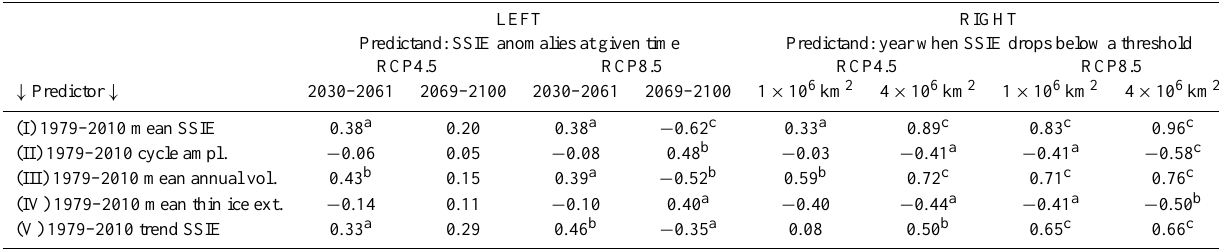
Table 2. Inter-CMIP5 models correlations between five 1979–2010 Arctic sea ice predictors (I mean SSIE; II amplitude of the mean seasonal cycle of sea ice extent; III mean annual volume; IV mean sea ice extent of thin (0.01–0.5m) ice in September; V linear trend in SSIE) and (LEFT) the 2030–2061 and 2069–2100 changes in SSIE with respect to 1979–2010 (RIGHT) the first year at which SSIE drops below 1 and 4millionkm 2 in September. Note that the number of models used for the calculation of correlations in the right part of the table can vary depending on the scenario and threshold. That is, only the models that cross the threshold before 2100 are considered in the correlations of the right part of the table. The correlations are calculated using the mean of the members for multi-member models, and the single available member for the others. LEFT RIGHT Predictand: SSIE anomalies at given time Predictand: year when SSIE drops below a threshold RCP4.5 RCP8.5 RCP4.5 RCP8.5 ↓ Predictor ↓